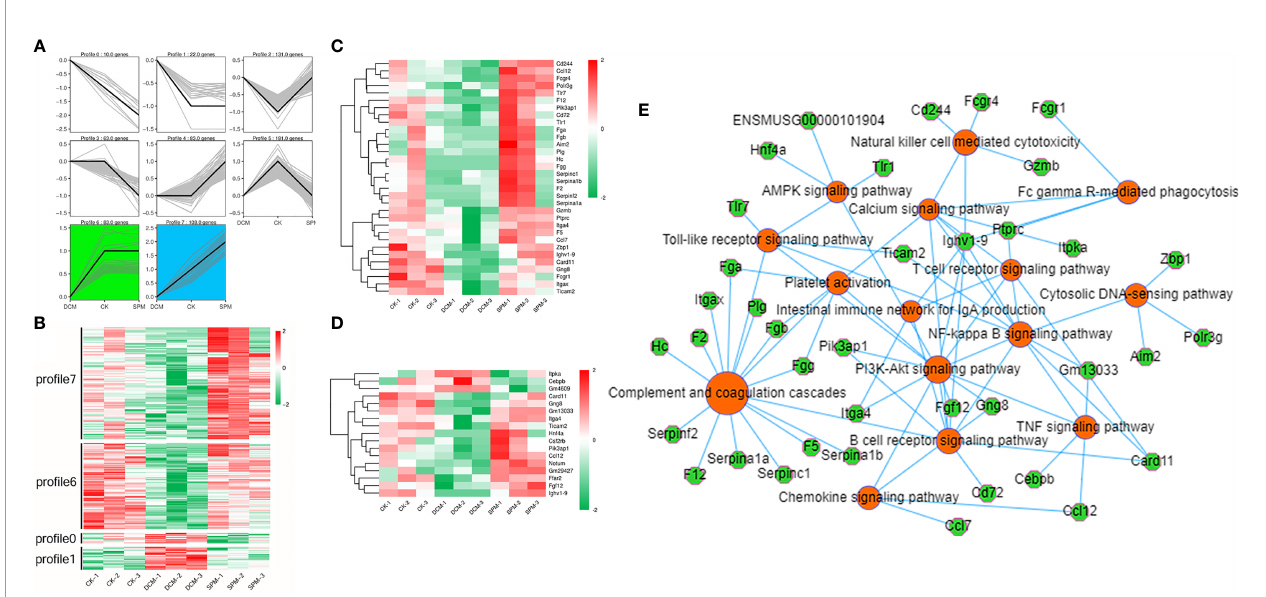
FIGURE 5 | Dynamic differential expression of genes in DCM mice heart before/after SPM treatment. (A) Trend analysis of DCM with or without SPM treatment. (B) Heat map shows the hierarchical clustering of genes in the pro fi les 0, 1, 6, and 7. The up- and downregulated genes are colored in red and green, respectively. Heat map shows the hierarchical clustering of the above genes in (C) immunity-related pathways or (D) signal transduction pathway. (E) KEGG network diagram shows the genes in the clusters 0, 1, 6, and 7 that are enriched in immunity and signal transduction pathways. Color orange and green represent pathways and genes,